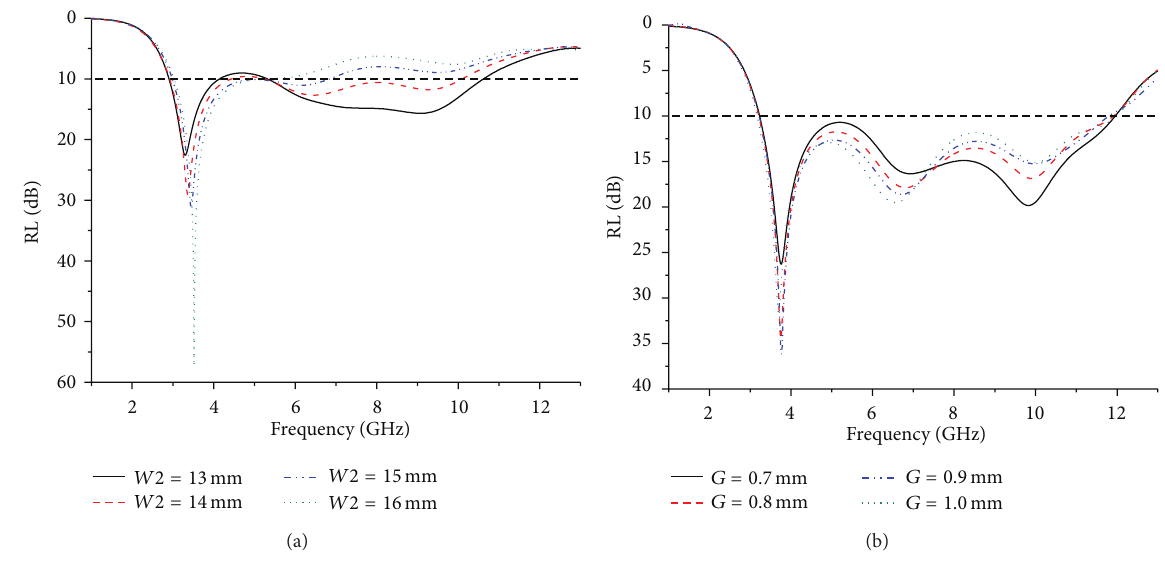
Figure 5: Return loss versus frequency (a) for different values of the parameter W2 (other parameters: G = 1mm, L2 = 11mm, Lg = 9 mm, L2 = 5mm, W1 = 20 mm, d1 = 0, and d2 = 0) and (b) for different values of the parameter G (other parameters: W2 = 5 mm, L2 = 11mm, Lg = 9 mm, L2 = 5 mm, W1 = 20 mm, d1 = 0, and d2 =